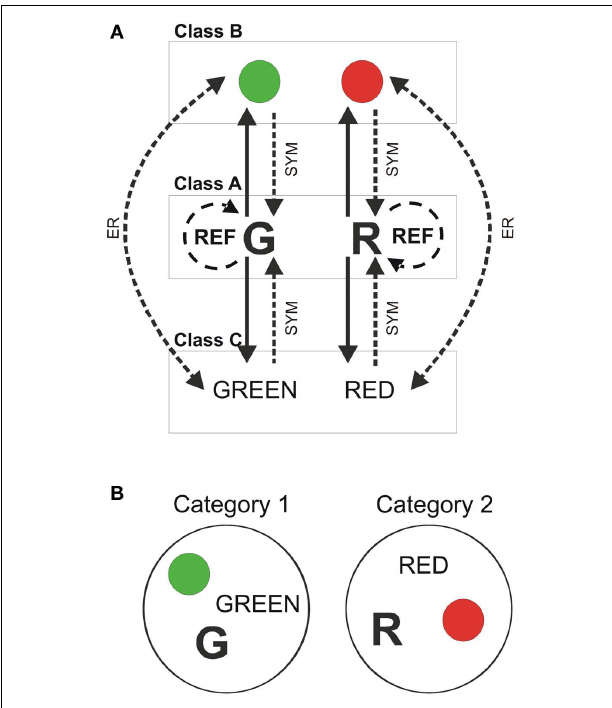
FIGURE 2 |Training and testing equivalence relations. (A) Three classes of perceptually different stimuli were used to train and test the paradigm. Simple conditional rules (continuous line) were reinforced in a delayed matching to sample experiment. Once individuals reached criteria in DMTS, they were tested in equivalence relations (dashed lines). REF: reflexivity test, SYM: symmetry test, and ER: equivalence relation test. (B) If the performance in the equivalence relations test is higher than 80%, the set of stimuli can be split in two new subsets, two logic categories of equivalent stimuli (Category 1 and Category